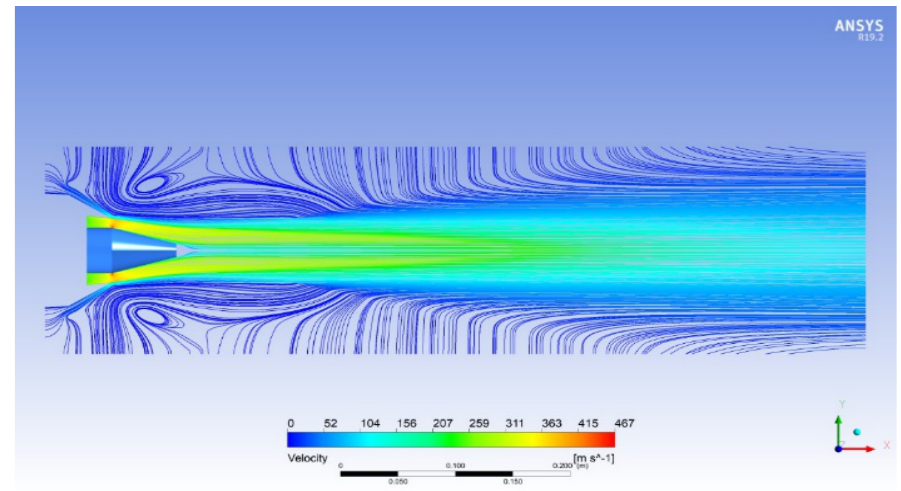
Figure 8. Velocity field and streamlines for the case when section 5 has a value of 3 mm.